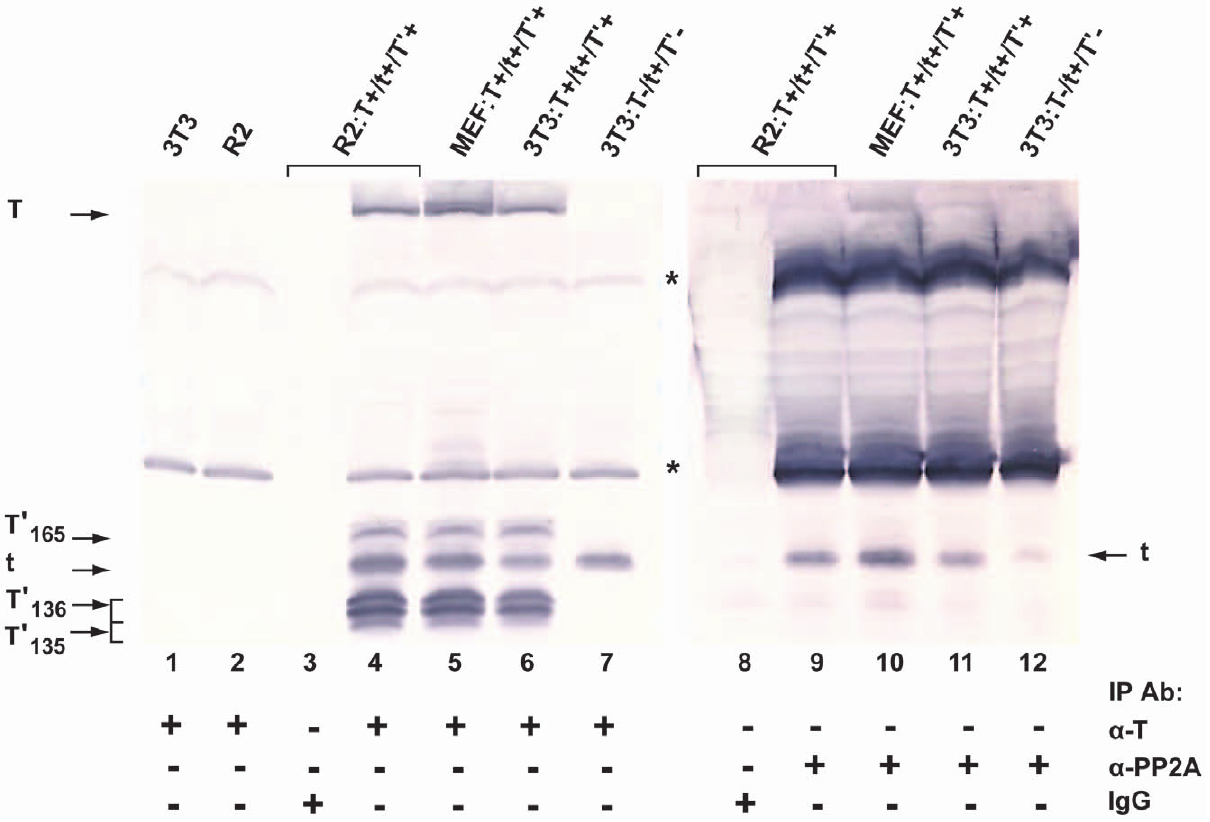
Figure 1. Wild type tAg interacts with cellular phosphatase PP2A in cells expressing JCV early proteins. JCV early proteins, expressed in Rat 2 (R2) or MEF cells transformed with pSR:T + /t + /T’ + or in G418-selected 3T3 cells transfected with pSR:T + /t + /T’ + (encodes all 5 JCV early proteins) or pSR:T 2 /t + /T’ 2 (encodes JCV tAg only) were incubated with anti-T monoclonal antibody PAb 962 ( a -T; lanes 4–7) or anti-PP2A antibody ( a -PP2A; lanes 9–12). The amount of total cell protein subjected to IP in lanes 9–12 was four times that employed in the corresponding samples in lanes 4–7. Immunoprecipitated proteins were separated on a 20% SDS-polyacrylamide gel, and WB analysis was performed using a cocktail of anti-T monoclonal antibodies to detect JCV early proteins either expressed in the different cell lines (lanes 4–7) or expressed and bound to PP2A (lanes 9– 12). Untransfected 3T3 and Rat 2 cells were included as negative controls (no JCV T proteins are present; lanes 1, 2), and a -mouse IgG was used in the IP step with the R2:T + /t + /T’ + cell extract to test for non-specific binding (lanes 3, 8). The asterisks denote antibody light and heavy chains. This figure represents proteins electrophoresed on a single gel and transferred to a membrane, which was then cut in half and each half developed for different lengths of